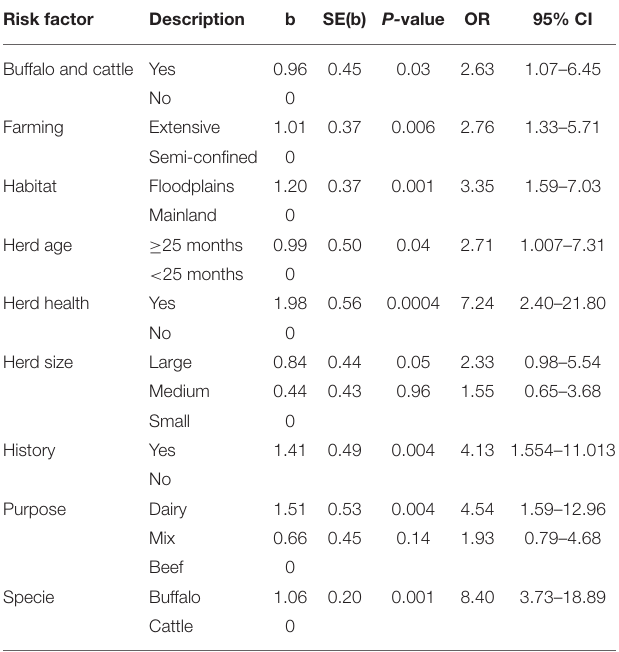
TABLE 6 | Univariate Logistic Regression of farm and individual-animal-level risk factors associated with the infection by M. bovis in 832 animals (106 cattle and 45 buffalo) in 39 herds in Amazonas